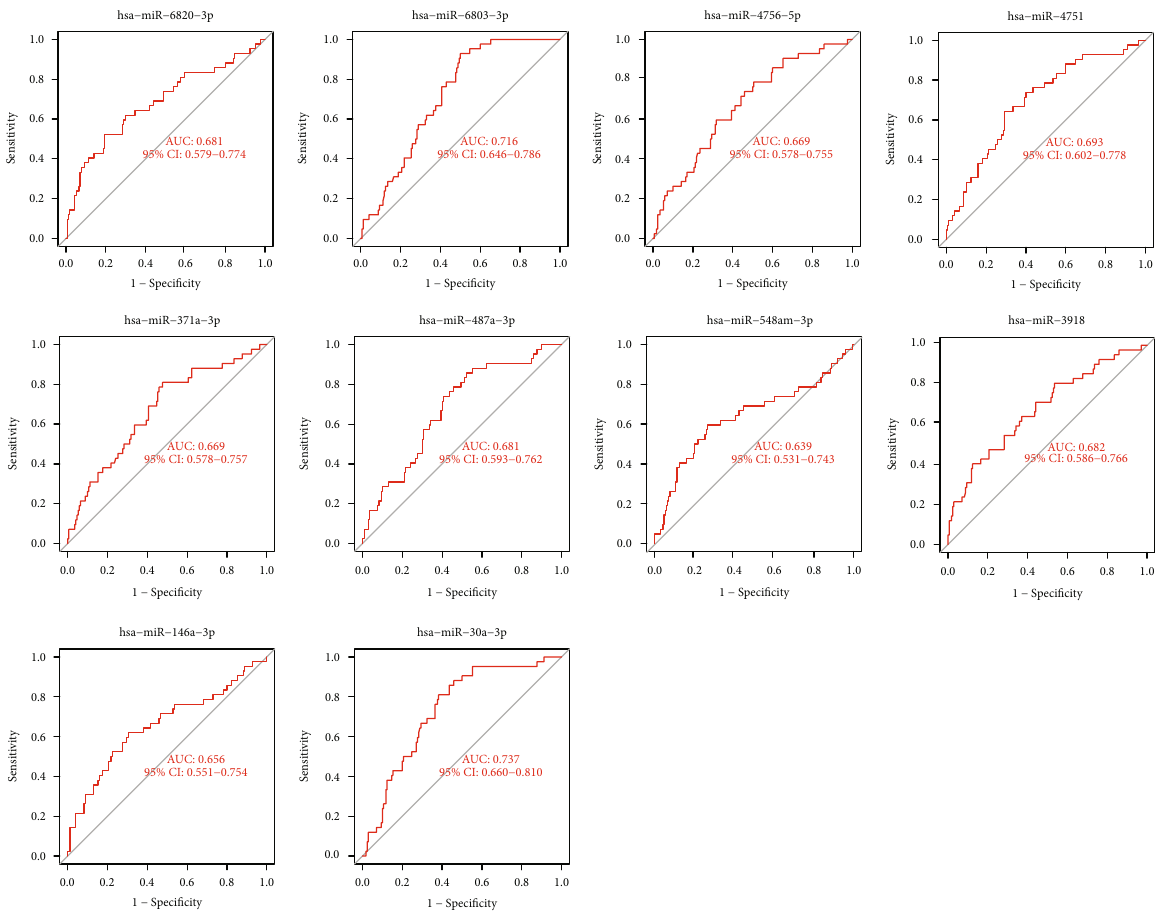
Figure 4: The ROC curve of diagnostic e ff ectiveness of then diagnostic markers, including miR-6820-3p, miR-6803-3p, miR-30a-3p, hsa- miR-4751, miR-3918, miR-146a-3p, miR-548am-3p, miR-371a-3p, miR-487a-3p, and